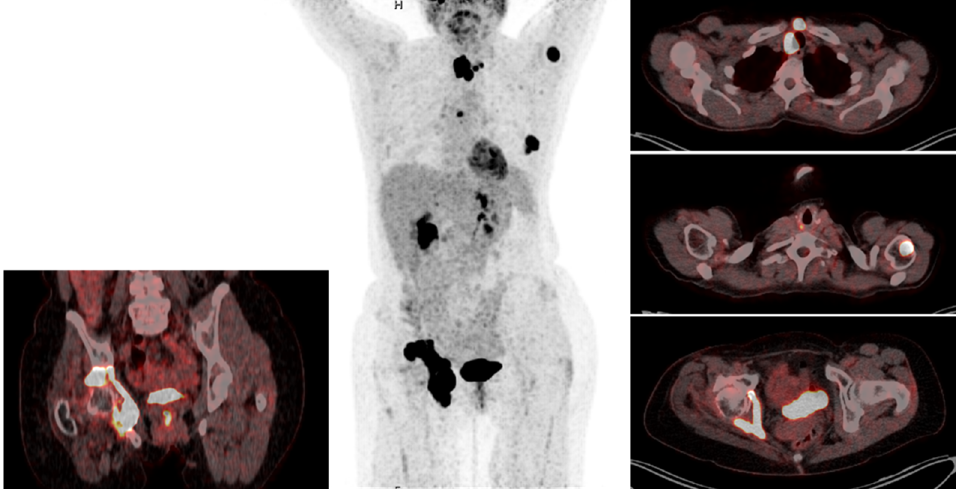
Figure 1. Cervical surgery in the setting of metastatic disease. This 55-year-old female patient underwent R0 resection of a minimally invasive pT3 cN0 cM0 FTC with vascular invasion 2014 and received her first RAIT. She first presented at our university clinic two years later, when she was diagnosed with cervical recurrence. She underwent cervical surgery, followed by cervical EBRT for diffuse soft tissue micrometastatic disease. Three years later, she was diagnosed with a new cervical relapse despite EBRT and a pelvic metastasis, which was deemed not resectable by orthopedic surgery. After her third cervical surgery in 2019, revealing soft tissue metastatic disease, she received a second RAIT and pelvic EBRT. These are the 18F-FDG PET scan and die DWBS six years after begin of disease. In addition to the pelvic metastasis and a further cervical relapse, new bone metastases are visible. The patient underwent her fourth cervical surgery this year. The trachea resulted superficially infiltrated over several cm, making a tracheal resection in the setting of metastatic disease not reasonable. A shaving resection was performed. Lenvatinib, which had been started 2020, was not tolerated well by the patient and treatment was discontinued. Disease is currently slowly